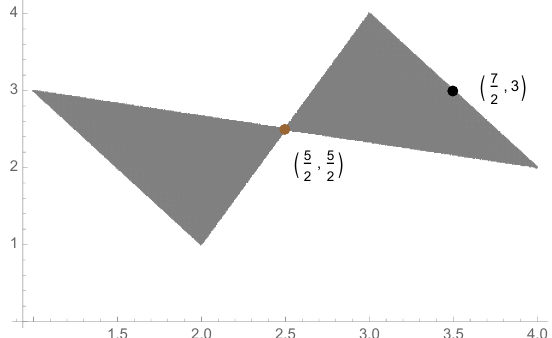
Figure 1. Payoff polygon for game (21) with the classical (brown) and quantum (black) equilibrium payoff